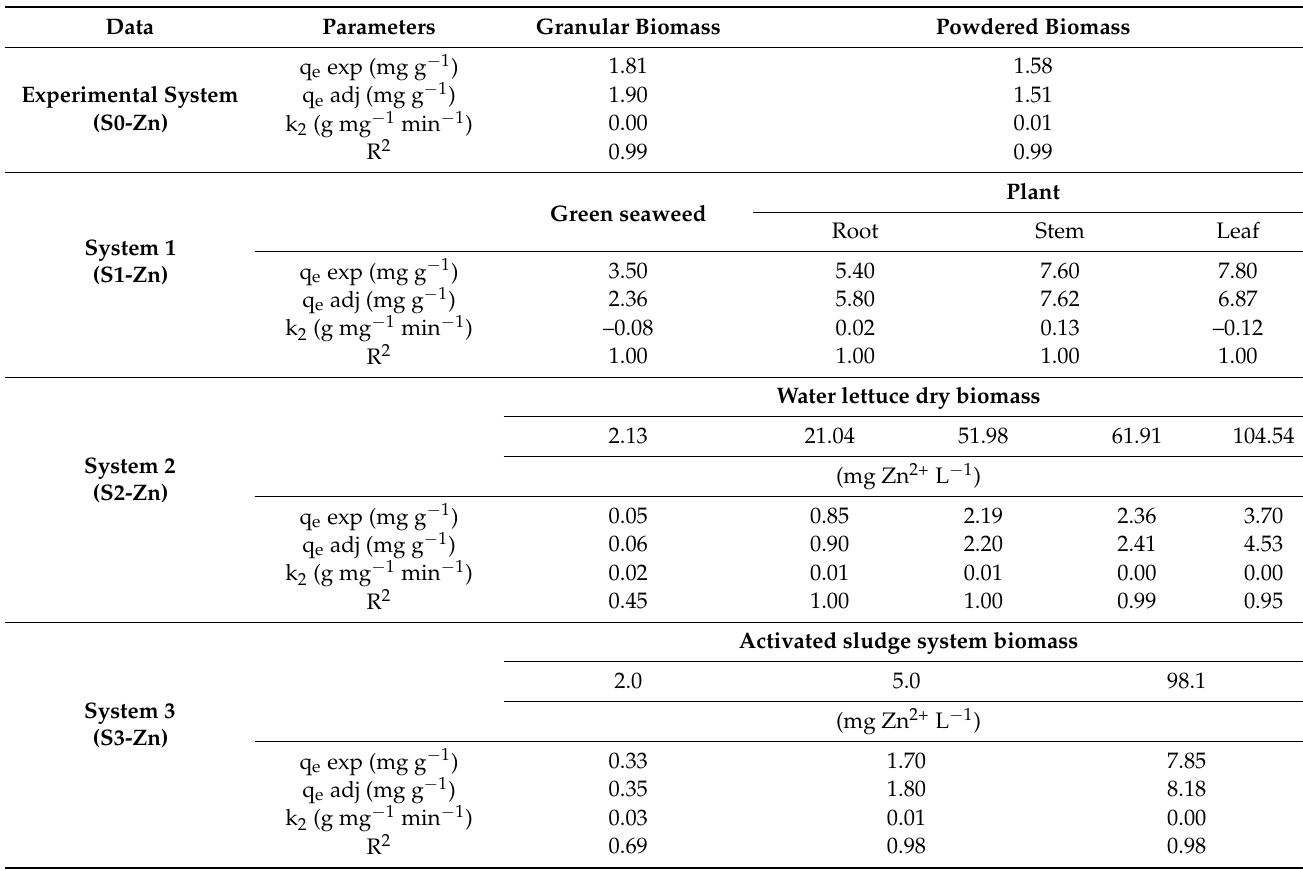
Table 6. Pseudo-second-order model parameters for zinc systems: S0-Zn, S1-Zn, S2-Zn and S3-Zn.